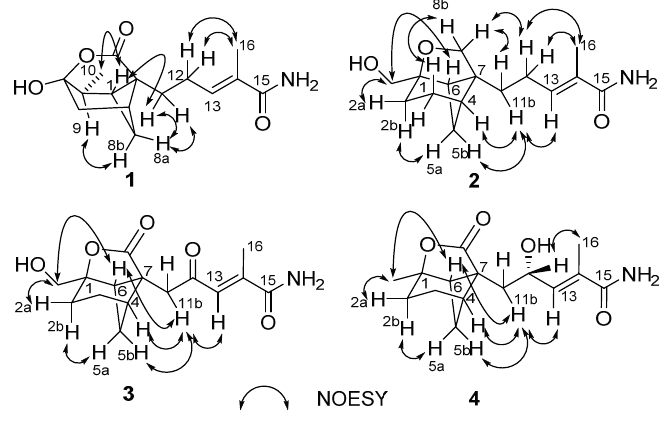
Figure 3. NOESY correlations for 1 – 4